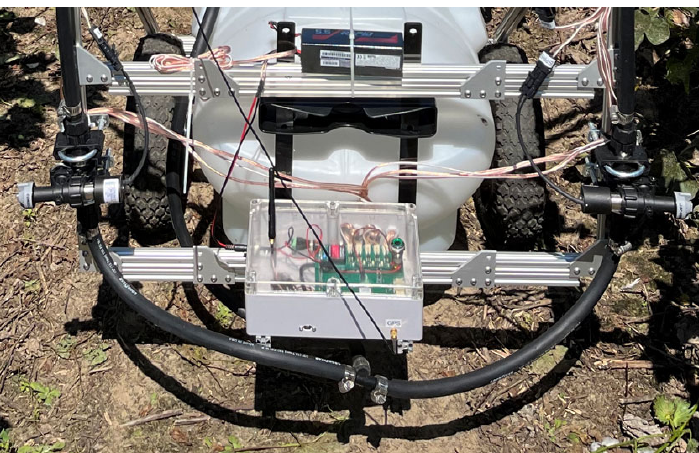
Figure 7. Placement of the sprayer unit enclosure.